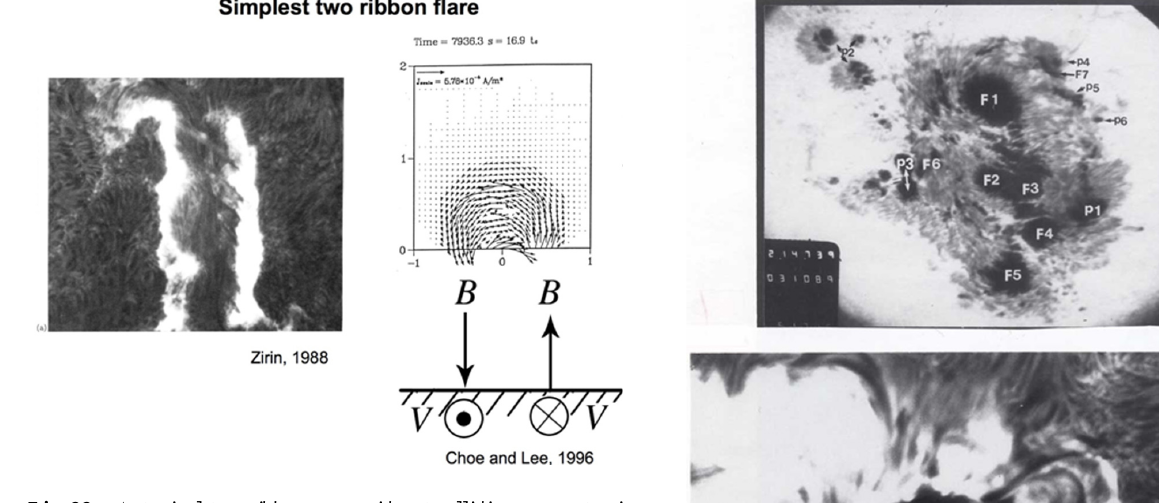
Fig. 22a. A typical two-ribbon flare without colliding sunspot pair (courtesy of H. Zirin) and the current system around the magnetic arch (Choe and Lee, 1995).